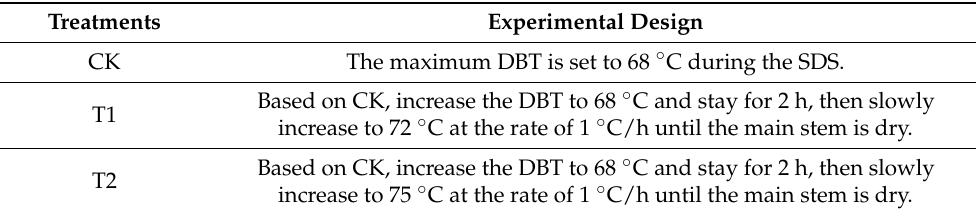
Table 1. Experimental design. Treatments Experimental